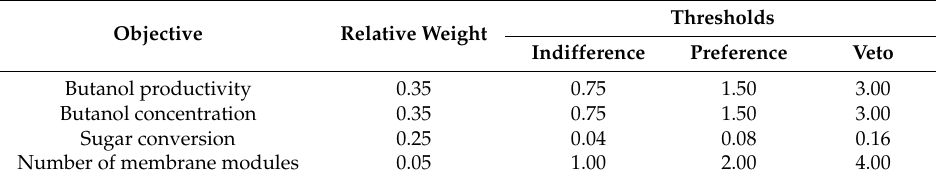
Table 2. Initial and reduced ranges of the decision variables.